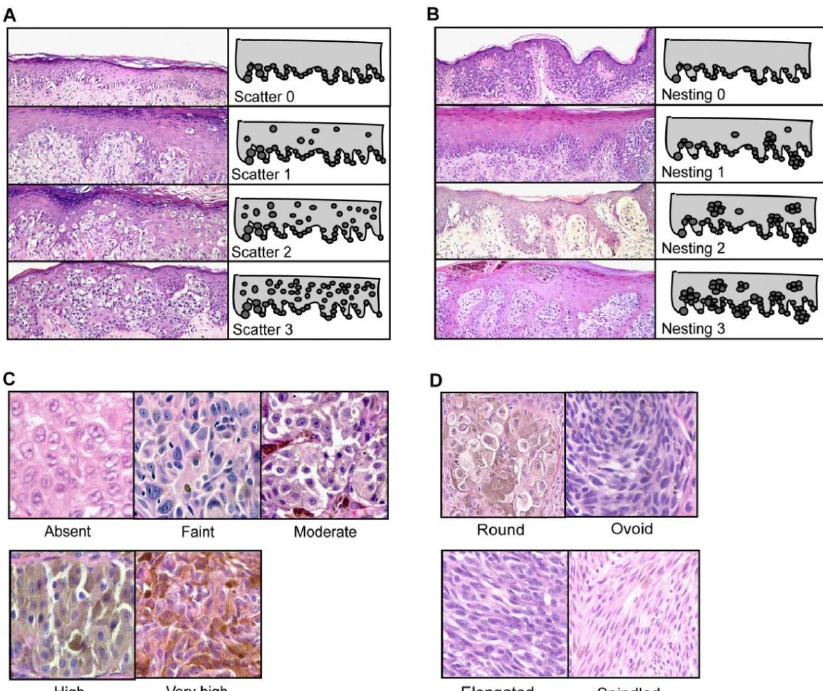
Figure 8. Grading of cellular morphological features (Reproduced from “Improving melanoma classification by integrating genetic and morphologic features” by Viros et al. under Creative Commons Attribution License from PLOS Med, © Viros 2008 et al. [47]). ( A ) Shows grading of scatter of intraepidermal melanocytes from 0 to 3, increasing in scatter. Grade 0 shows all melanocytes along the dermal–epidermal junction; grade 1 shows > 75% of melanocytes along the dermo-epidermal junction, with some present higher in the epidermis; Grade 2 showed equal amounts of intraepidermal melanocytes at the junction and higher in the epidermis; Grade 3 is noted when > 50% of intraepidermal melanocytes are in the upper epidermis, ( B ) shows the grading of nesting of intraepidermal melanocytes from 0 to 3. The amount of nesting is quantified here as: Grade 0: Intraepidermal melanocytes present as single cells with rare nests; Grade 1: Intraepidermal melanocytes arranged as single cells with < 25% of cells in nests; Grade 2 Intraepidermal melanocytes in nests in 25%–50%; Grade 3: > 50% of intraepidermal melanocyte population are arranged in nests, ( C ) Cytoplasmic pigmentation of neoplastic melanocytes, Scaled 0–4. Score of 0 meant no pigmentation is present; Score 1: Faint pigmentation barely visible at low power; Score 2: Moderate pigmentation visualized at low power; Score 3: High pigmentation easily visible at low power, pigmentation of cytoplasm is similar to the nucleus pigmentation intensity; Score 4: Very highly pigmented cytoplasm, often obscuring nuclei [47]. ( D ) Cell shapes were also graded 0–3, Grade 0: Round cell with equal diameter and length; Grade 1 was ovoid with a diameter 1 / 3 longer than the short diameter; Grade 2 is elongated with a long diameter 1 / 3–2 times longer than the short diameter; Grade 3 is spindled with a long diameter two times the shorter diameter